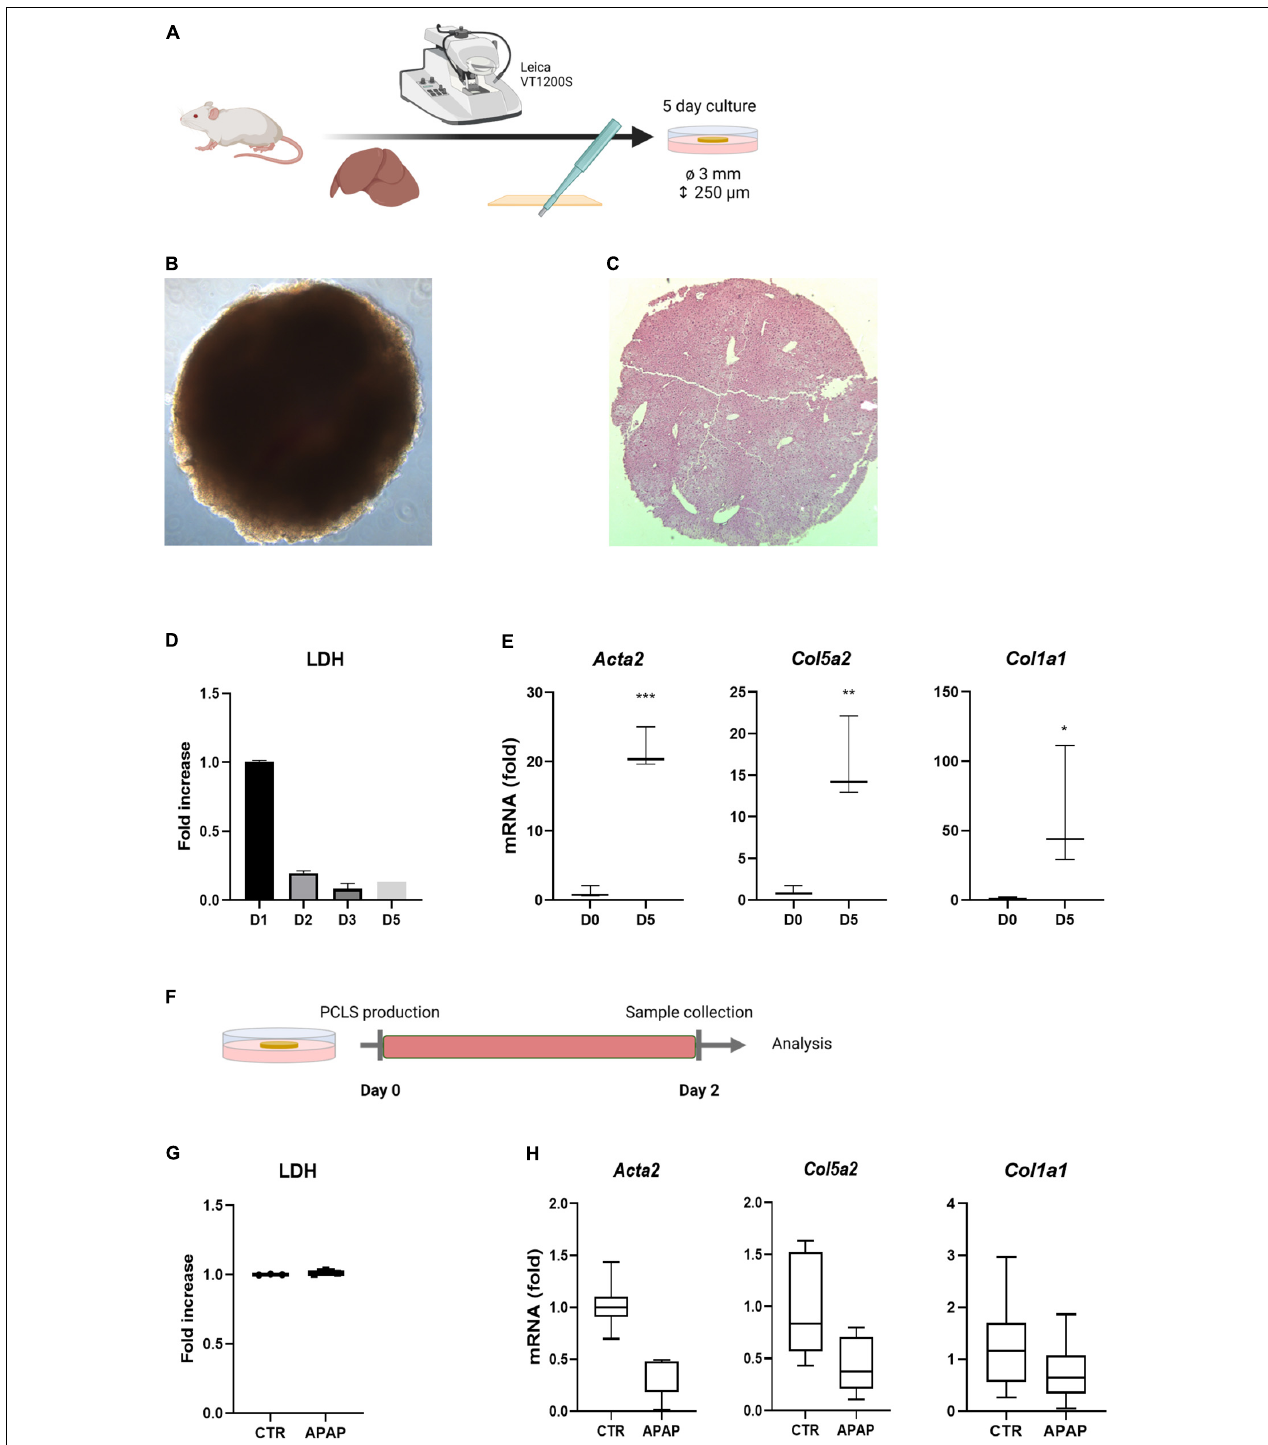
FIGURE 1 | Standard culture conditions do not allow drug-induced fibrosis modeling. (A) Liver tissue is sliced with a vibratome and subsequently punched with a biopsy puncher, resulting in 250 µ m thick discs with a 3 mm diameter. PCLS are cultured for 5 days in regular WME medium. (B) Microscopic picture of freshly sliced 3 mm liver slice. (C) H&E staining of a freshly sliced 3 mm liver slice. (D) Medium of cultured PCLS shows high levels of LDH leakage on day 1, which are strongly reduced from day 2 on ( n = 3). (E) mRNA levels of HSC activation markers is significantly increased upon culture time. Fold increase to day 0 ( n = 3). (F) PCLS were exposed to 1 mM APAP the first 48 h of culture and medium and slices were analyzed for respectively. (G) LDH levels ( n = 3) (H) mRNA levels of HSC activation markers. Fold increase to untreated 48 h PCLS cultures ( n = 6). * p ≤ 0.05, ** p ≤ 0.01, *** p ≤ 0.001.